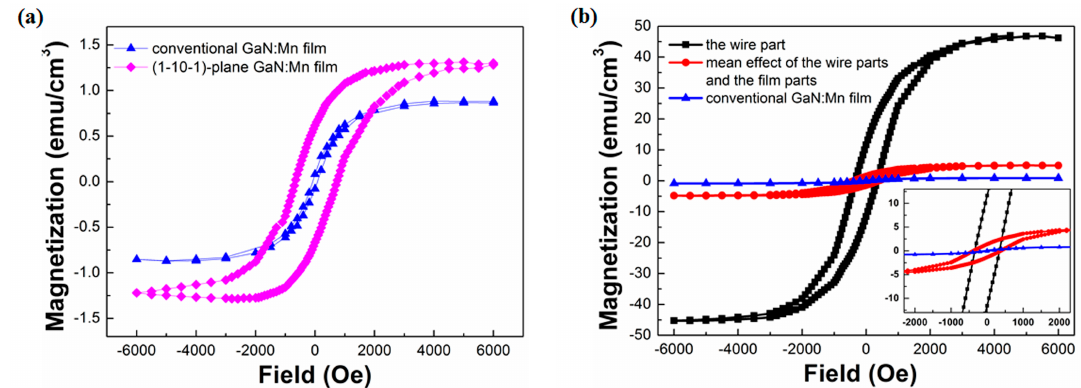
Figure 3. ( a ) Hysteresis loops of the (1-10-1) plane GaN:Mn film and the conventional GaN:Mn film at 300 K; and ( b ) hysteresis loops of the GaN:Mn wire part, the overall mean effect of the film part and the wire part, and the conventional GaN:Mn film at 300 K. Inset: an enlarged image of the zero field part of the hysteresis loops.